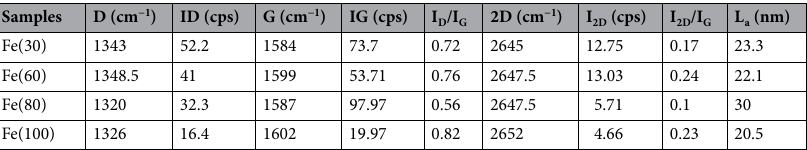
Table 2. Values of D, G and 2D bands and their related intensities with a comparison of I D /I G and I 2D /I G for MW heated samples.